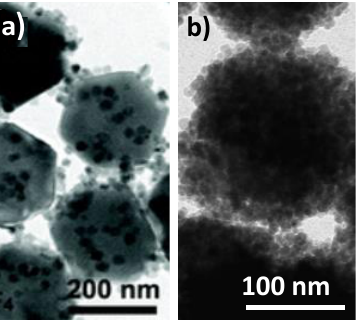
Figure 24. TEM images of (a) NaYF 4 :Yb 3+ -Er 3+ @Fe 3 O 4 and (b) NaYF 4 :Eu 3+ @Fe 2 O 3 particles. Reproduced from [196] and [231], with permissions from John Wiley and Sons, 2014, and MDPI, 2020, respectively.